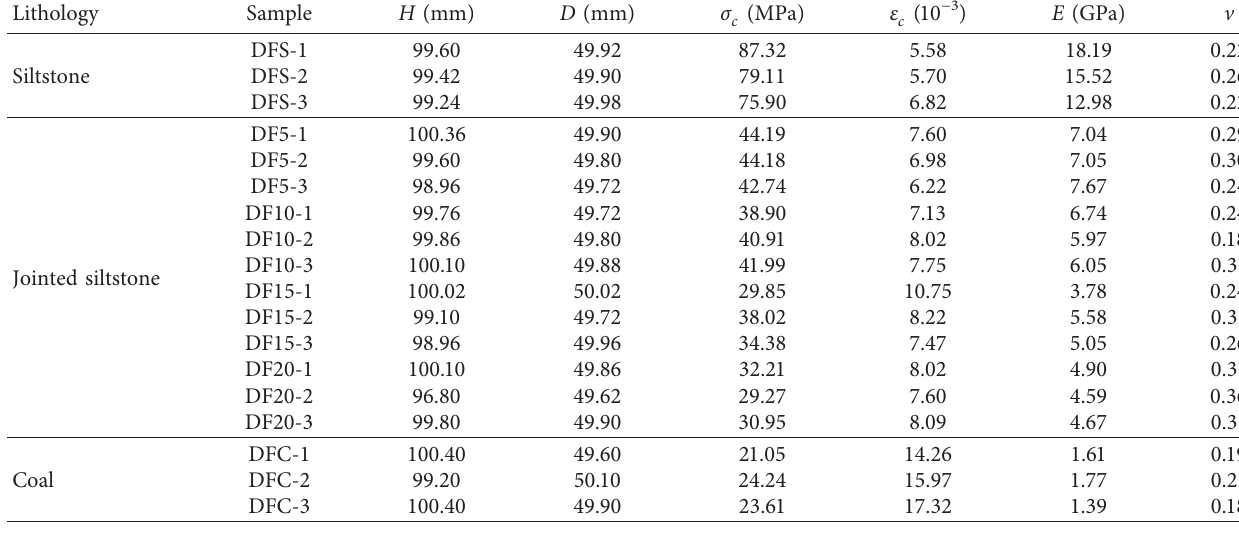
Figure 3: Fabricated specimens with joint thickness of (a) 5mm, (b) 10 mm, (c) 15mm, and (d) 20 mm. Table 1: Mechanical parameters of specimens under uniaxial